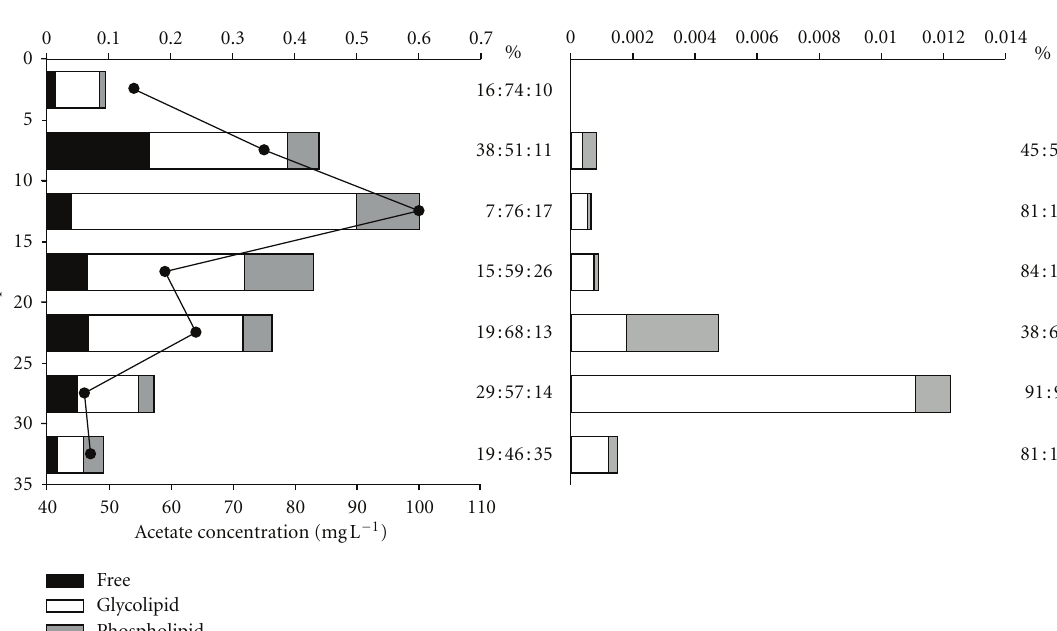
Figure 3: Concentrations of archaeol and crenarchaeol ( μ gg − 1 dry wt soil; bars; for quantification details refer to Section 2), and acetate (mgL − 1 ; circles) with depth at Caeau Ton-y-Fildre. Black, white, and dark grey bars represent free lipids and ether lipids bound by glycolipid moieties and phospholipid headgroups, respectively, in the case of archaeol; for crenarchaeol, white bars include both simple lipids and